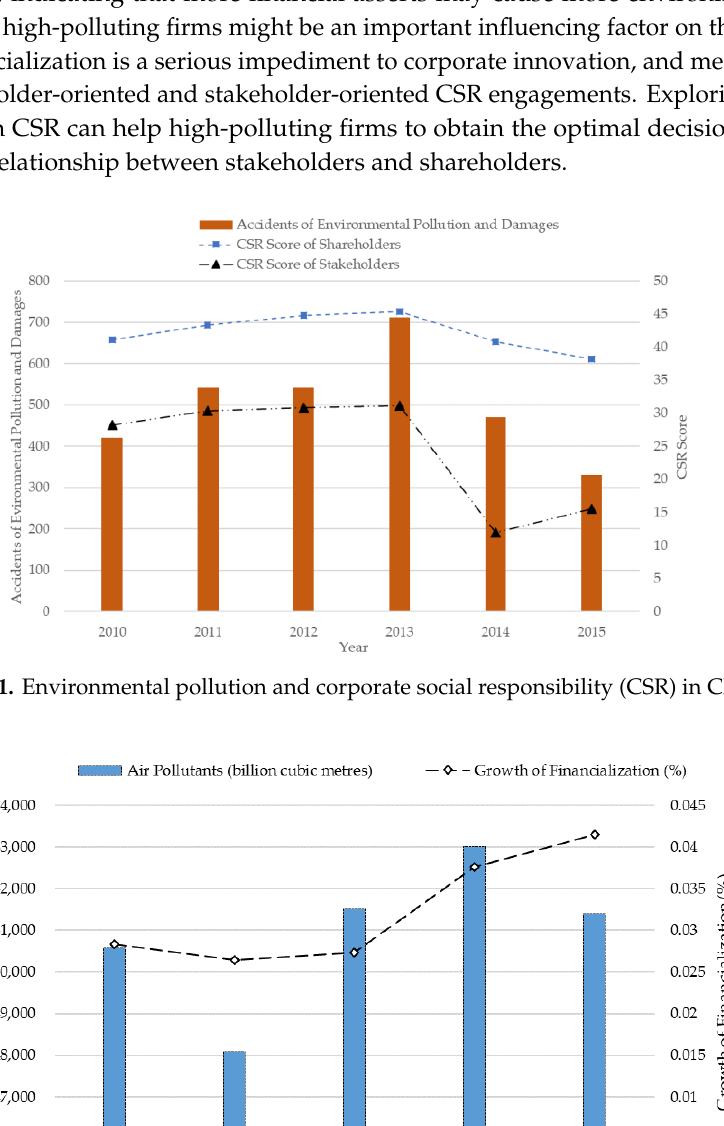
Figure 2. Air pollutants and financialization of high-polluting industries in China.